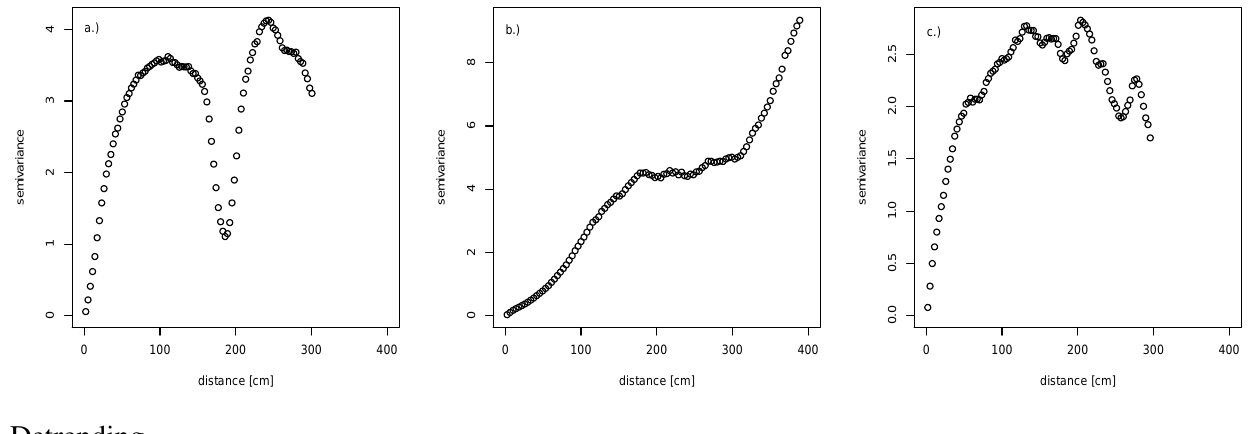
Figure 5. Sample variograms of the roughness plots from Figure 4 showing ( a ) a significant two scale roughness pattern (R12), ( b ) a spatial trend (R14) and ( c ) no spatial trend with an insignificant two scale roughness pattern